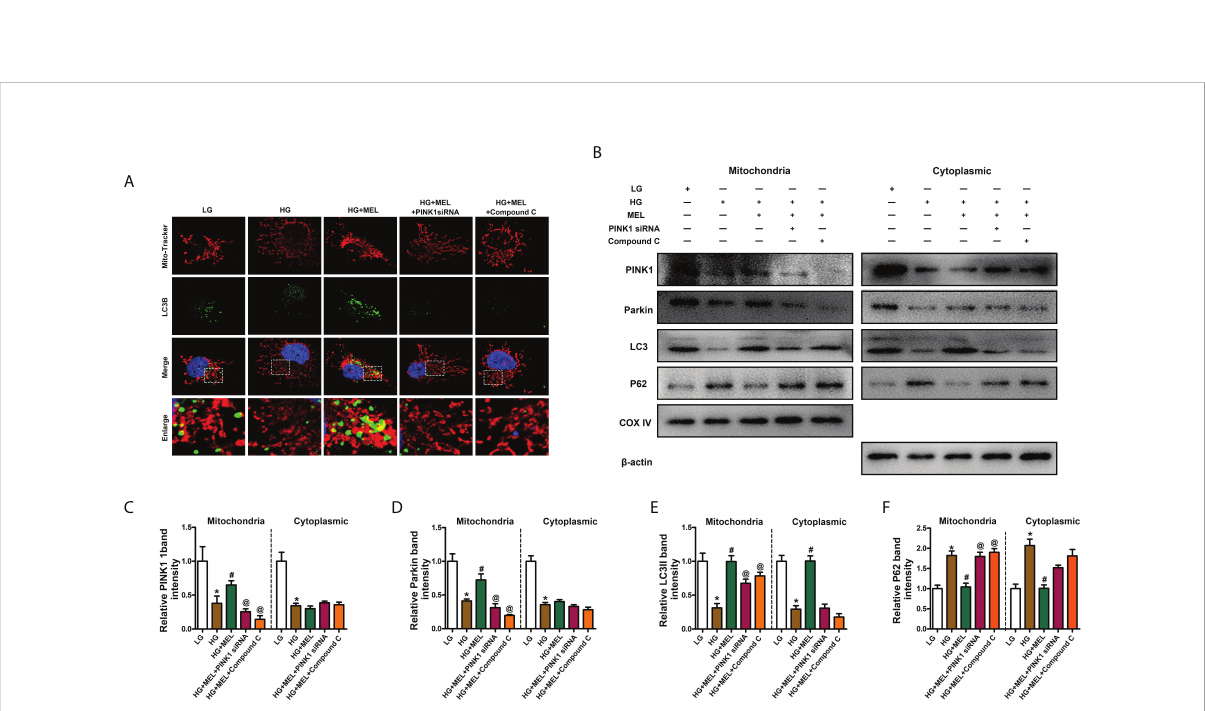
FIGURE 5 Metformin activated mitophagy in HK-2 cells treated with HG through the p-AMPK-PINK1 pathway. Mitophagy was detected by co-staining of MitoTracker and LC3B (A) . Western blot analysis of PINK1, Parkin, Parkin, LC3II, and P62 protein expression in mitochondria (left panels) and cytoplasm (right panels) (B) . Quantitative analysis of PINK1 (C) , Parkin (D) , LC3II (E) , and P62 (F) . The values are the mean ± SD. n = 4/group. *p < 0.05 compared with the control group; # p < 0.05 compared with the HG group. @ p < 0.05 compared with the HG+MEL group.